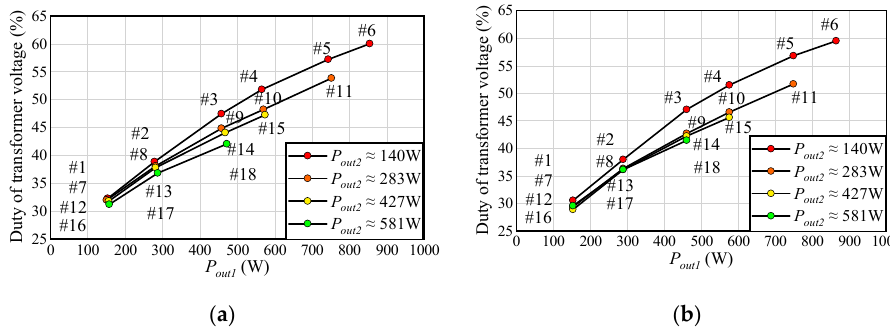
Figure 13. Waveforms of proposed circuit: ( a ) Experimental results; ( b ) Simulation results. Figures 14 and 15 present the relationships between D tx and P out 1 and f tx and P out 2 , respectively, in steady operation for the measurement and simulation. In addition, the difference between the experimental results and the simulation results for Figures 14 and 15 are depicted in Figure 16. Figures 14–16 indicate the experimental tests are operated by larger D tx and lower f tx than the simulation tests under all load conditions. The reason for the larger D tx is that D tx compensates for V out 1 decreased by the conduction losses of parasitic resistance in the actual circuit and the reason for the lower f tx is that f tx controls increasing V out 2 with increasing D tx . Although these errors appeared, it can be observed that the values of D tx and f tx at all operation points in steady operation were close to the simulation results. Therefore, the verification circuit also operated as per the simulation analysis at other operation points that are not shown in the waveforms of Figure 13. This is a further demonstration of the efficacy of the proposed control method.